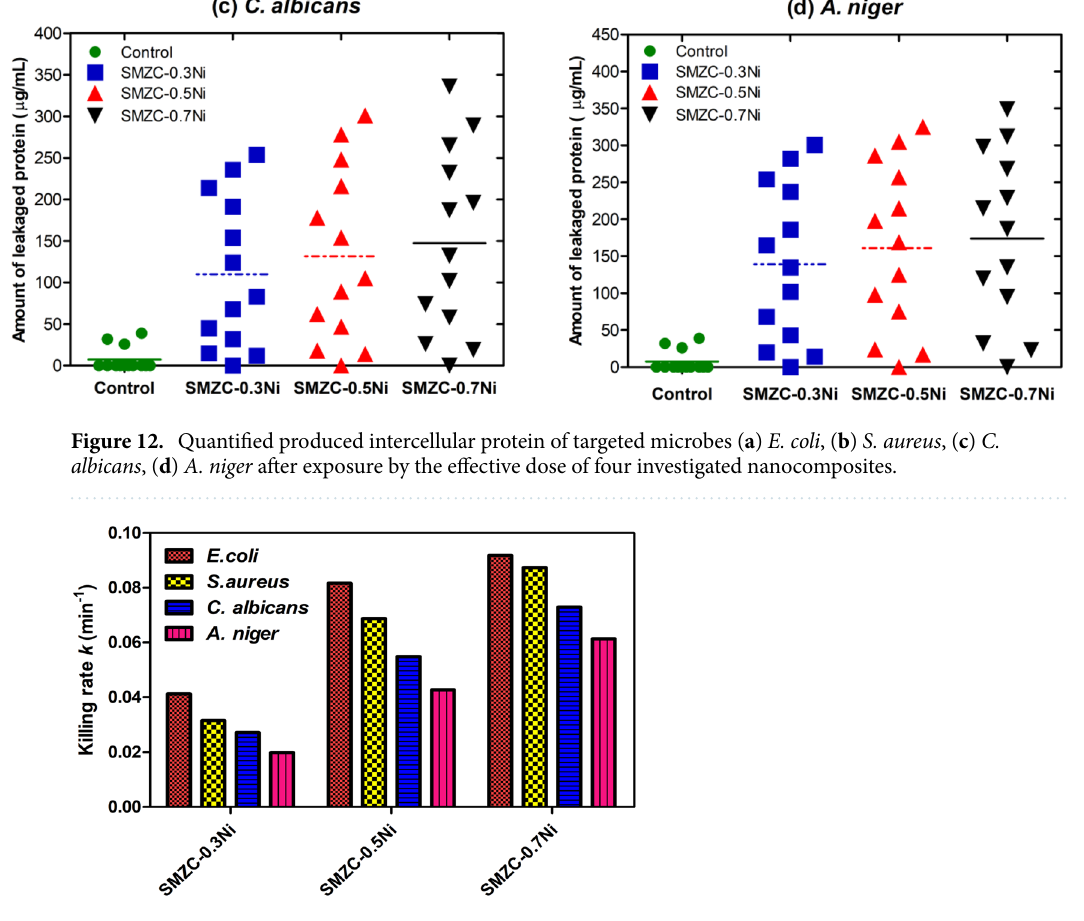
Figure 13. Decaying speed of targeted pathogenic microbes by 100 mg/L of examined nanocomposites via pseudo-first-order kinetic